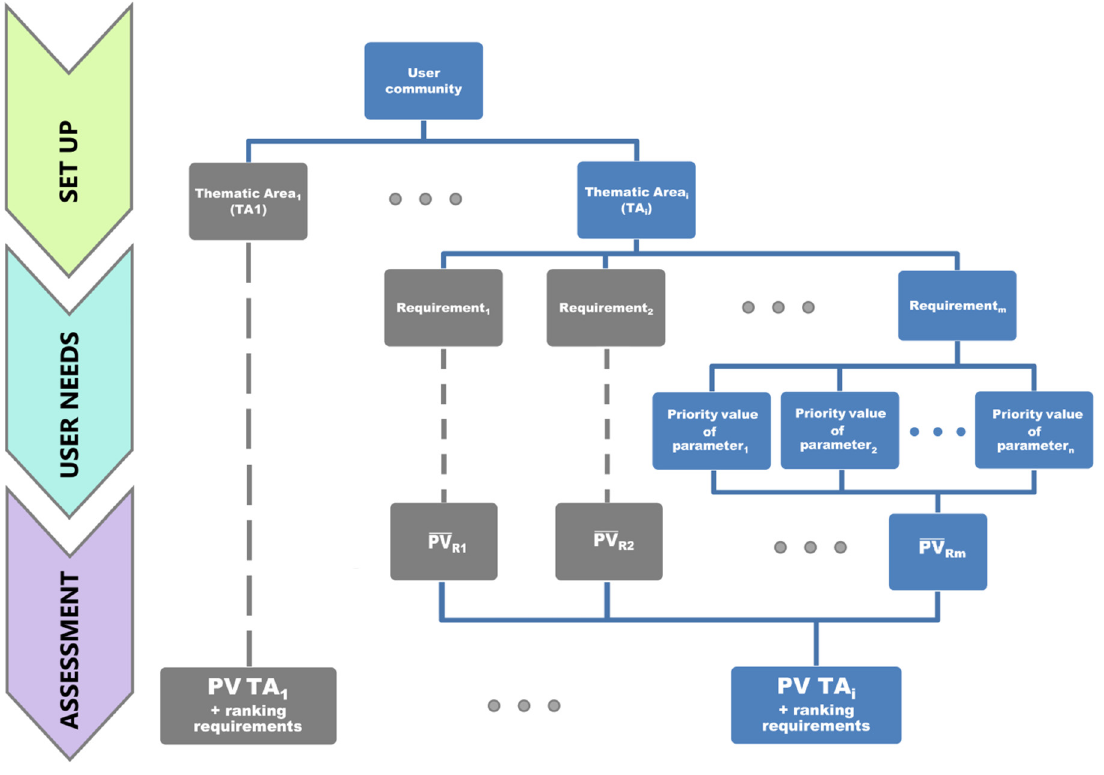
Figure 4. Flow chart of the user requirement assessment.